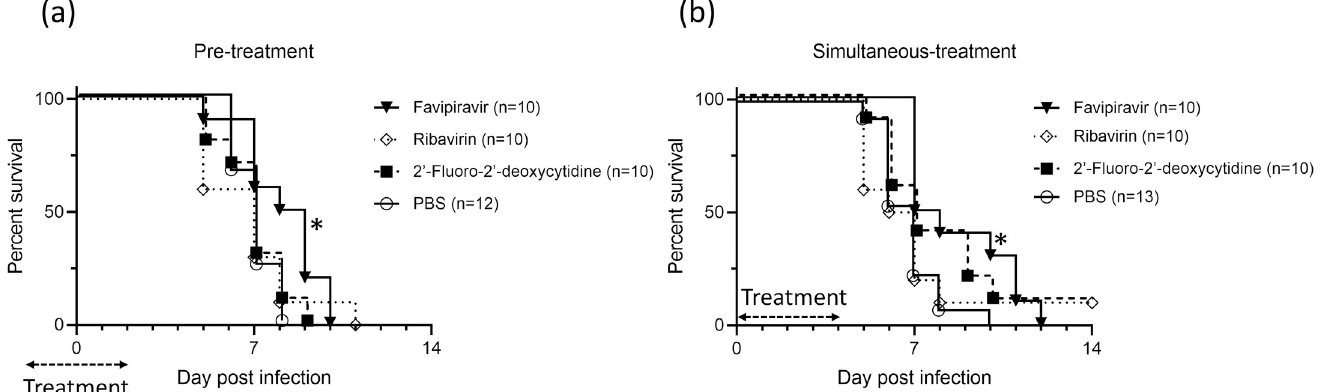
Fig 3. Survival of JCV-infected C57BL/6J mice treated with FPV, RBV, and 2’-FdC. Five mice in each group were inoculated intracerebrally with 1.0 × 10 4 TCID 50 JCV. The combined data of the two independent experiments are shown. Treatments were commenced (a) 2 days prior to virus inoculation (pre-treatment) or (b) on the same day of virus inoculation (simultaneous-treatment) and continued for 5 days. The mice were treated intraperitoneally with FPV (300 mg/kg/day), RBV (100 mg/kg/day), 2’-FdC (100 mg/kg/day), or PBS as negative control once a day. Survival was determined using the Kaplan-Meier analysis. Asterisks denote significant differences (p <